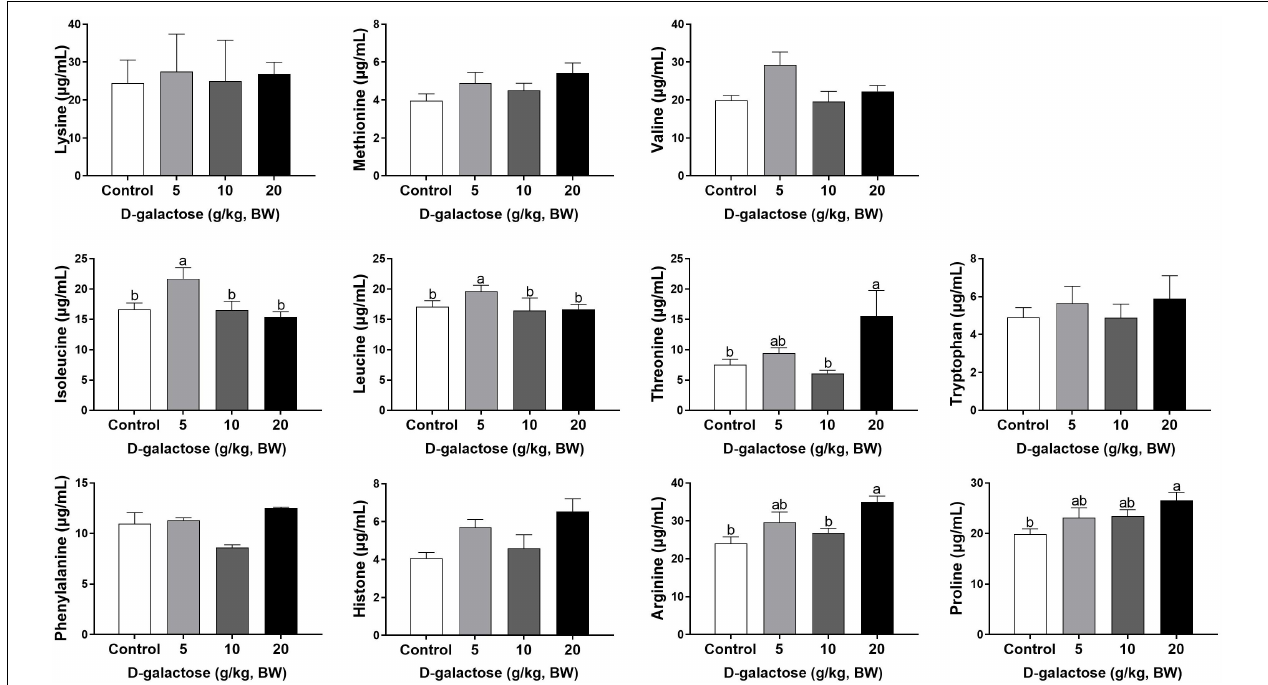
FIGURE 8 | Effects of D -galactose on essential amino acids in the serum at the third week. Data were expressed as the mean ± SEM. Different lower-case letters indicate a significant difference among different dosage of D -galactose ( P < 0.05).